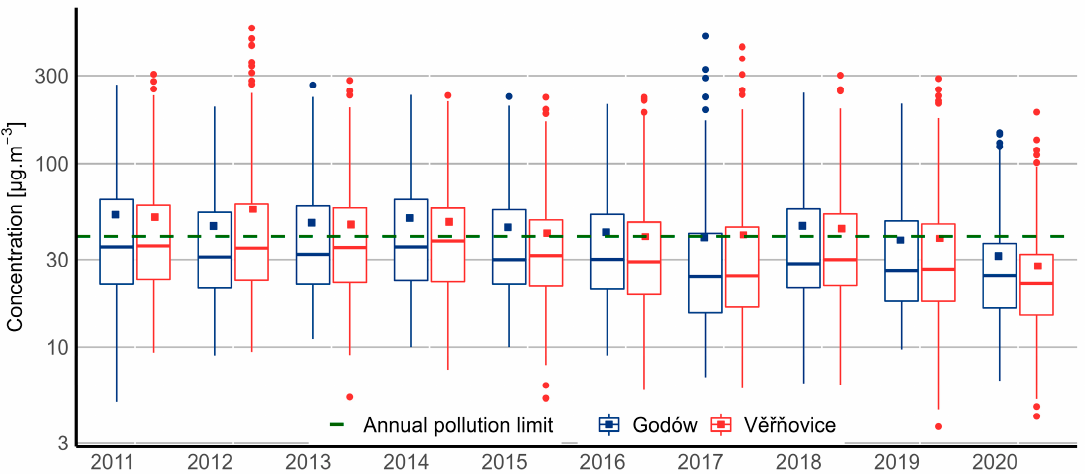
Figure 4. Boxplot of daily PM 10 concentrations, Godów and V ěřň ovice stations, 2011–2020 (blue and red squares indicate average concentrations).